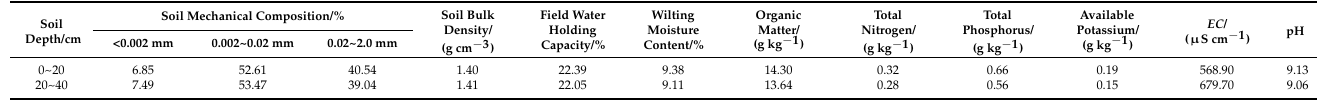
Figure 2. Lysimeter schematic plot. Table 1. Physical and chemical properties of test